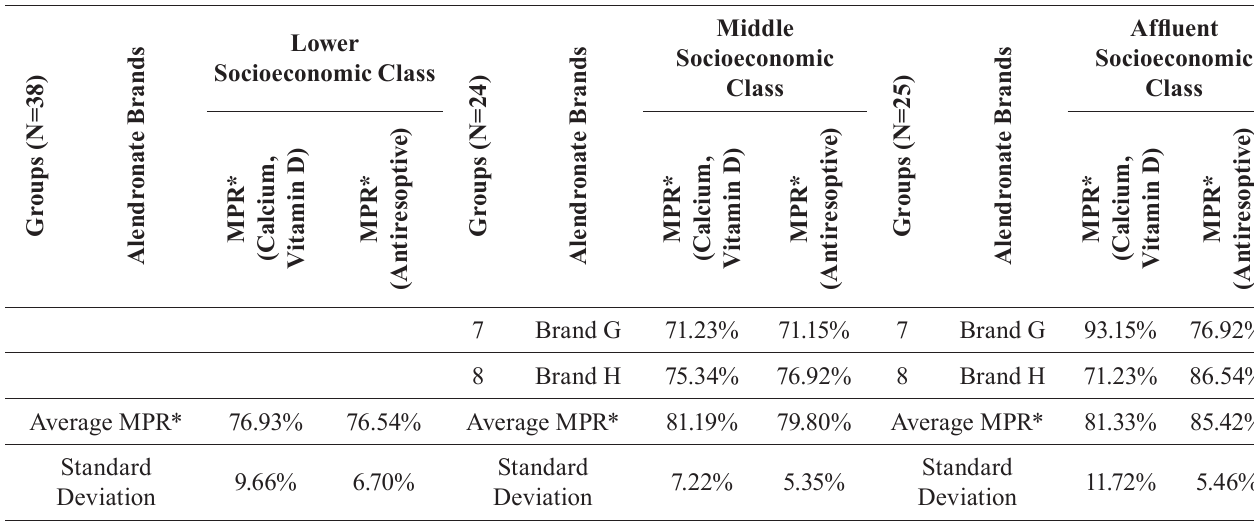
TABLE V - M PR of Alendronate Brands, Calcium, Vitamin D in different Socioeconomic Classes